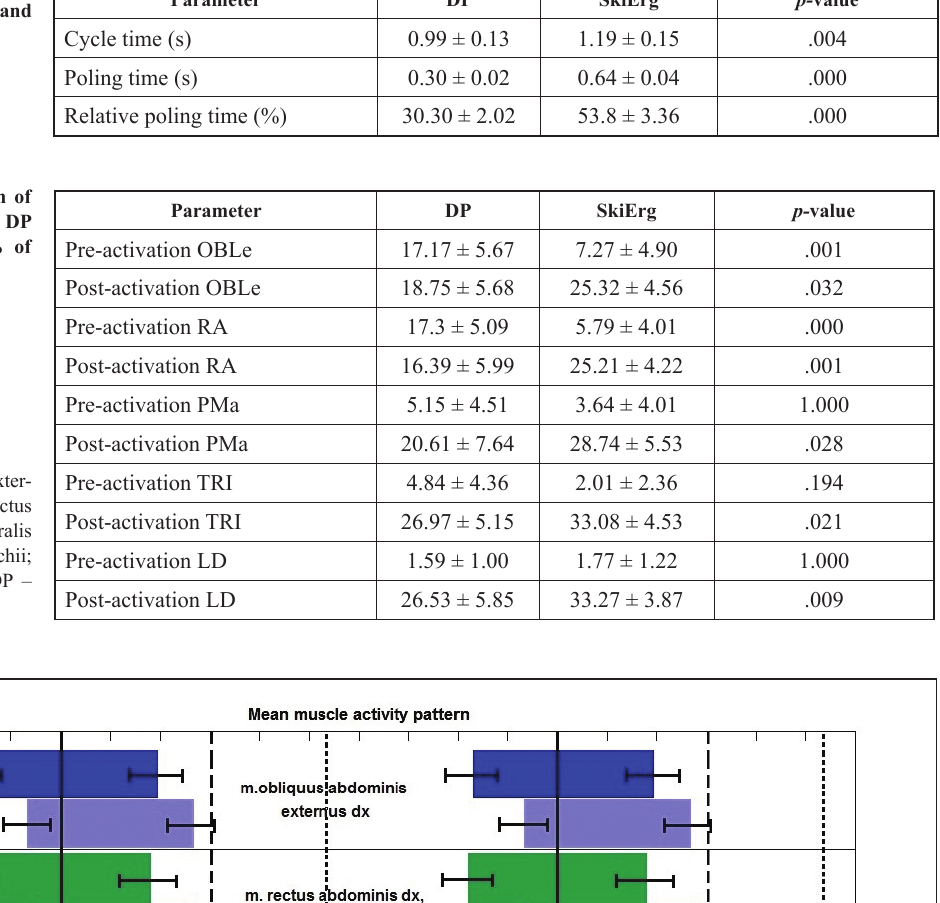
Table 1. Cycle and poling time